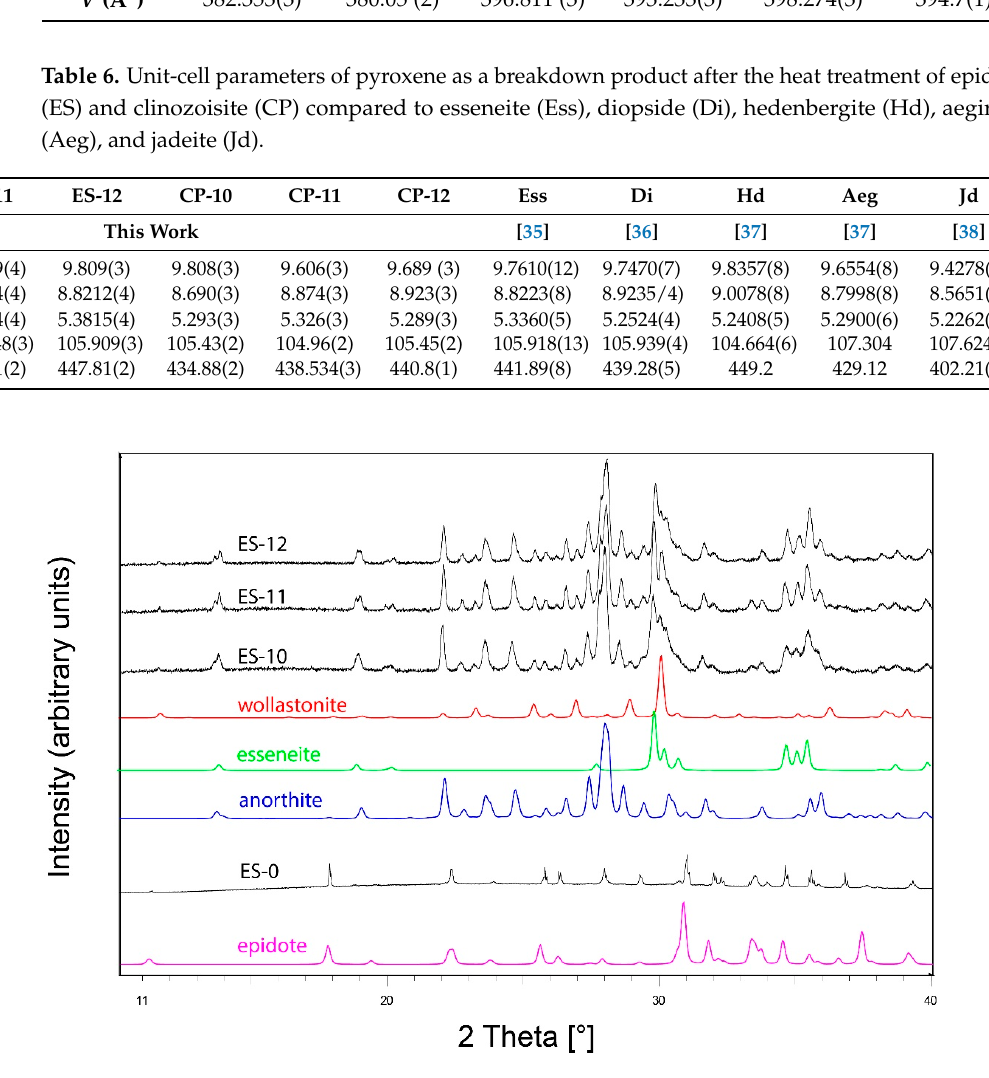
Figure 5. Powder X-ray diffraction patterns of clinozoisite experimental samples (CP) compared to patterns of wollastonite [39], anorthite [40], esseneite [33], and clinozoisite [14] (modeled from structural data using pseudo-Voigt function).